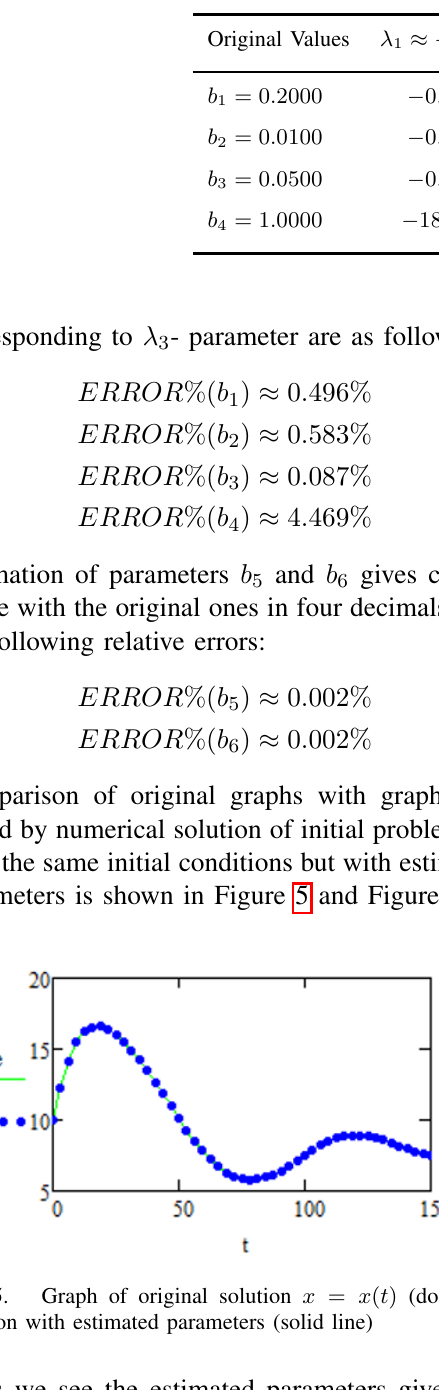
of nonlinear equation (12): λ 1 ≈ − 0 . 2391 , λ 2 ≈ − 0 . 0725 , λ ≈ 0 . 1899 3